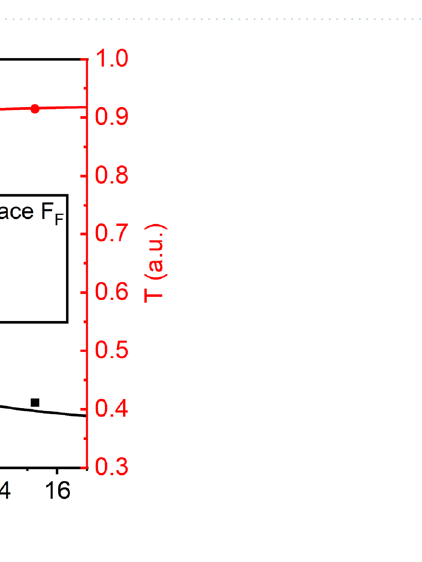
Figure 5. Surface fill factor (F F ) and transmittance (T) as a function of the sheet resistance (R sh ) values for electrodes with varying number of layers. The smooth lines correspond to the nonlinear fit